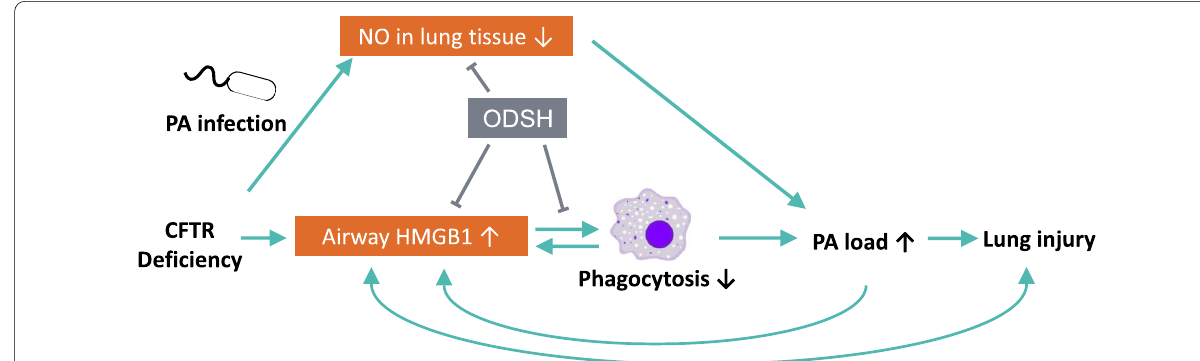
Fig. 8 Schematic summary of the effects of ODSH on attenuating lung injury in cystic fibrosis by targeting airway HMGB1. Deficiency or dysfunction in CFTR gene or protein leads to an elevation of airway level of HMGB1. High levels of airway HMGB1 can compromise host defense in bacterial clearance by impairing the ability of macrophages to phagocytose the invading bacteria, resulting in increased bacterial loads in the lung and subsequently causing lung injury. Increased bacterial load in the lung and lung injury can further stimulate the release of proinflammatory mediators, including HMGB1, into the airways, establishing a deleterious cycle to cause sustained pulmonary infections and severe lung injury. Nitric oxide (NO) also plays a critical role in host defense to clear invading bacteria. However, CFTR deficiency leads to a decrease of bacterial infection-induced NO production in the lung, which can contribute to impairing host defense in clearing the invading PA. Administration of ODSH to CF mice can improve the bacterial clearing by (1) attenuating CF-suppressed NO production induced by bacterial infection in the lung, (2) decreasing the airway accumulation of extracellular HMGB1 released by necrotic cells of the injured lung as well as actively secreted by macrophages and (3) decreasing the HMGB1-mediated macrophage dysfunction. Importantly, ODSH can bind directly to HMGB1, inducing its conformational changes which might be responsible for the reduced HMGB1 binding to its receptors (e.g. TLR2 and TLR4) on macrophages. Together, ODSH protects the CF lung upon bacterial infection by attenuating HMGB1-induced innate immune dysfunction. Thus, ODSH ultimately enhances host defense in bacterial clearance by augmenting macrophage phagocytic ability, which leads to attenuating lung injury in